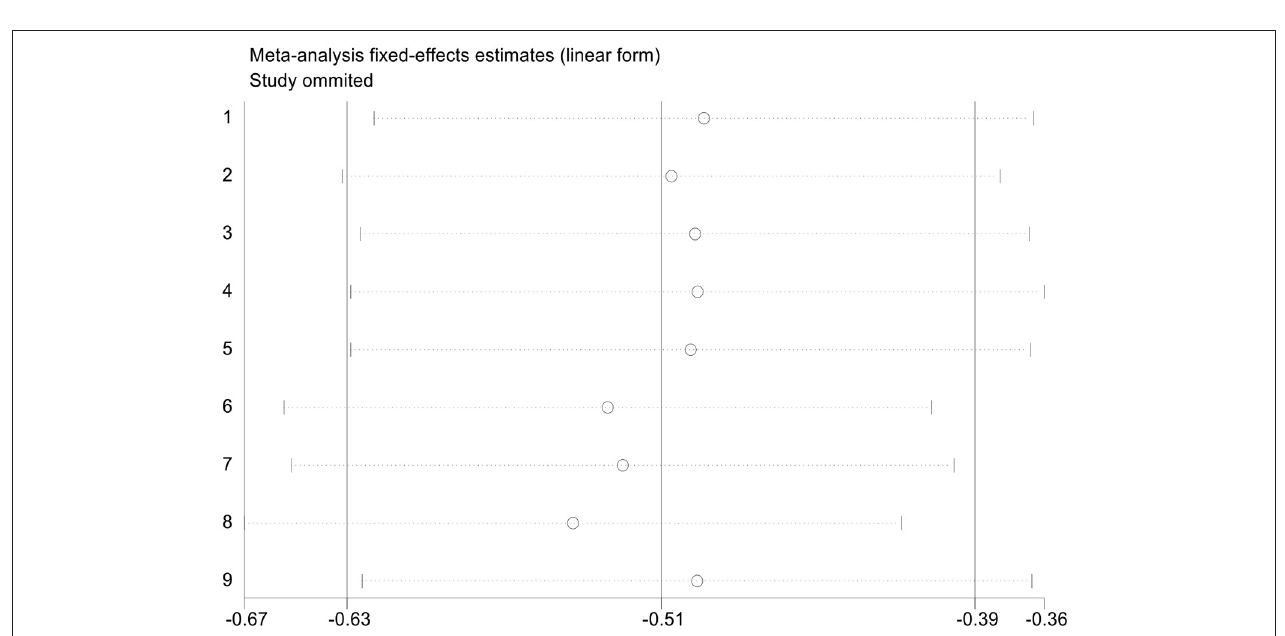
FIGURE 3 | Sensitivity analysis of Association between vitamin D level and